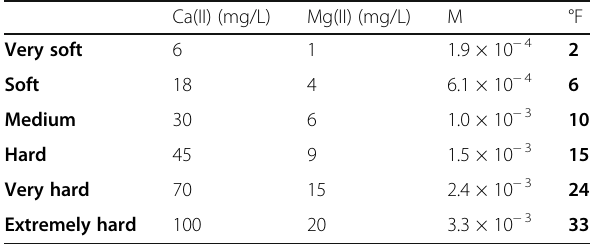
Table 2 Composition of the solutions used to build the PLS model for the water ’ s